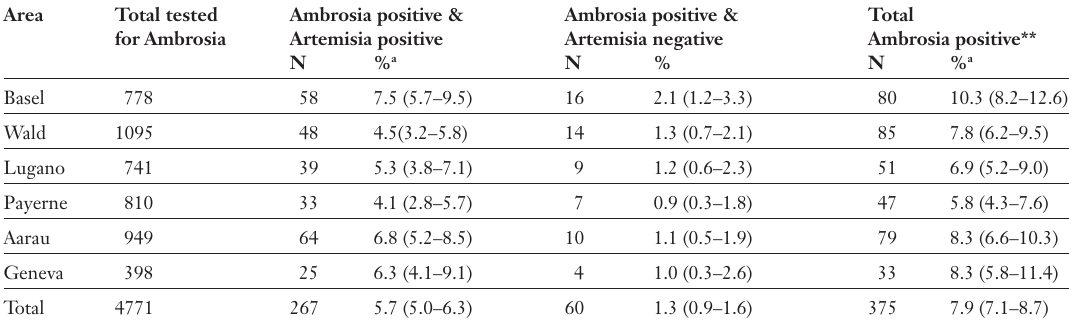
* Montana and Davos excluded. ** Numbers exceed the sum of the N’s of the subcategories defined by Artemisia sensitisation status since some subjects who were sensitised to Ambrosia had missing or invalid data on Artemisia sensitization. a Percentages with 95%-confidence intervals.